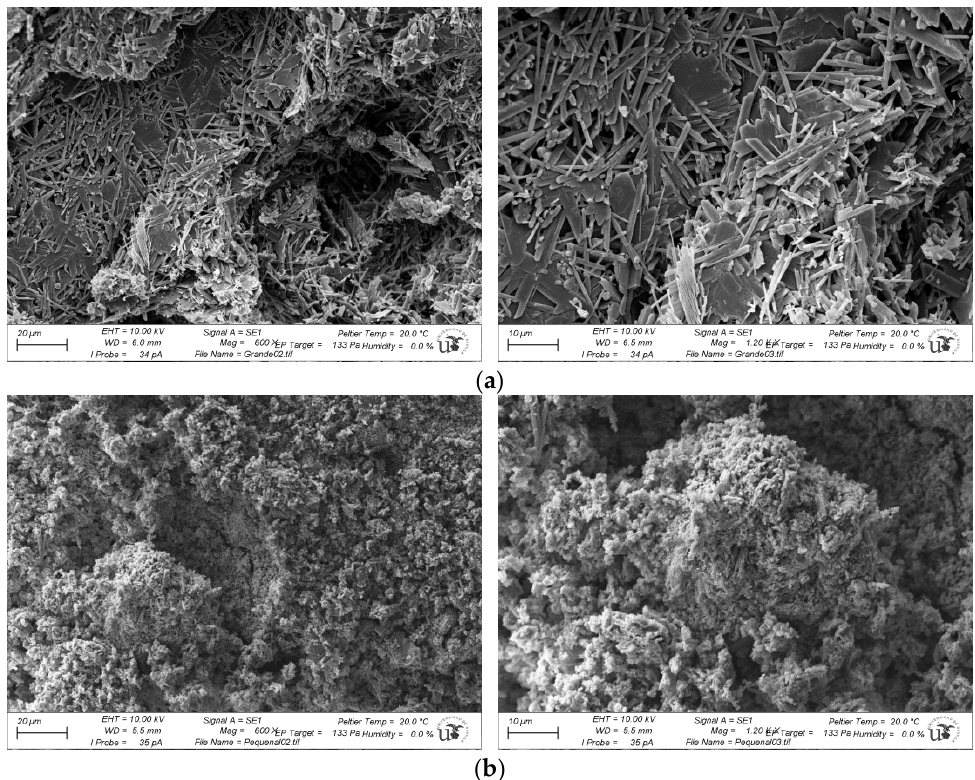
Figure 6. SEM images obtained for gypsum plasters ( a ) Reference material; ( b ) GBC-1.